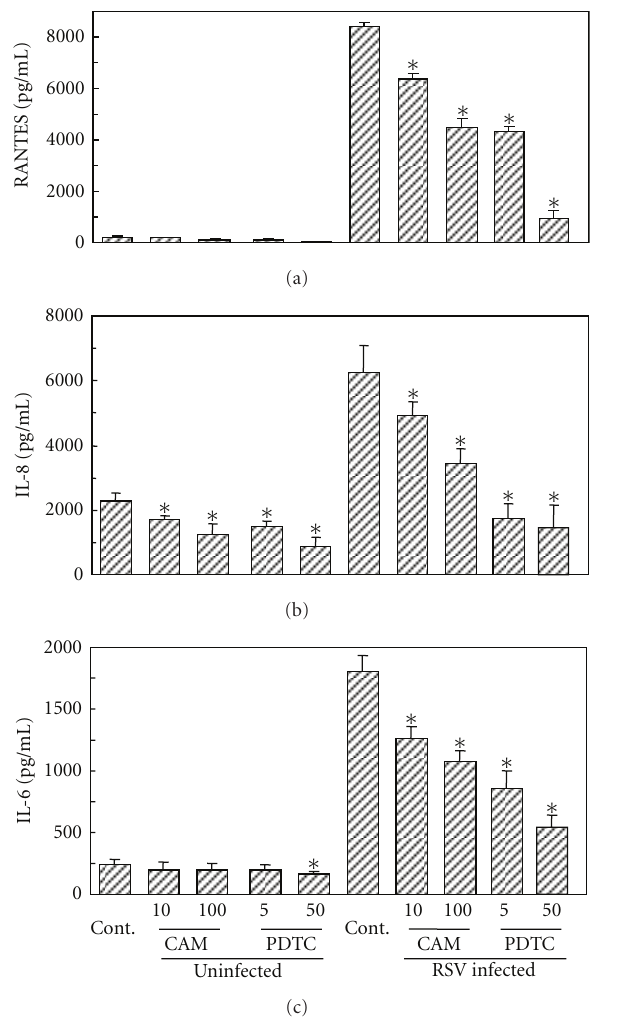
Figure 2: E ff ects of CAM and PDTC on RSV-induced RANTES (a), IL-8 (b), and IL-6 (c) production in A549 cells. One hour before RSV infection, CAM or PDTC is added to A549 cell culture at the indicated concentration. A549 cells were infected with the RSV at MOI of 1. After 24 h of infection, the culture supernatants were collected, and each cytokine in the supernatants was determined by ELISA. The experiments were performed in triplicate. The mean value and standard deviation were calculated. Statistical di ff erence was examined by Student’s t -test. ∗ P < 0 . 01 compared to cytokine production without any reagent treatment in uninfected cells and RSV-infected cells, respectively.